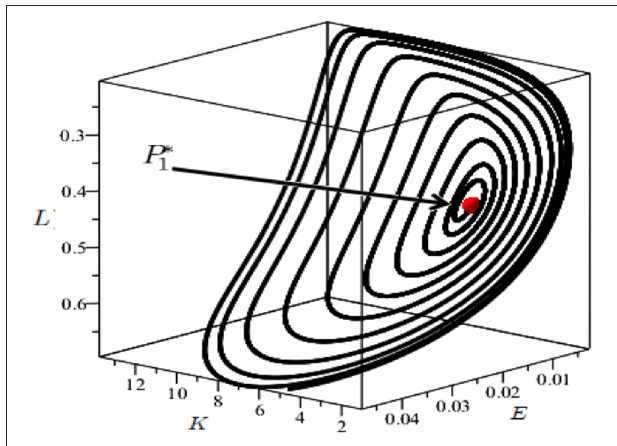
FIGURE 13 | Parameter set: α = 0.1, β = 0.8, γ = 0.58, δ = 0.05, ǫ = 1, η = 1.5, θ = 0.001, E =